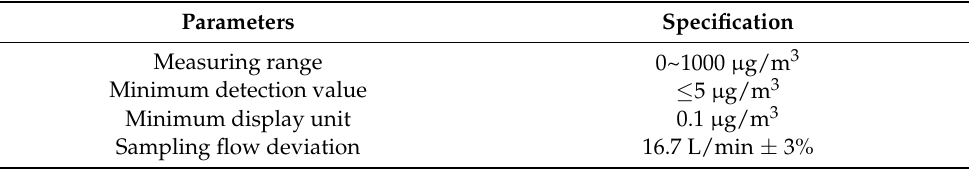
Table 3. The specifications of the ambient air quality